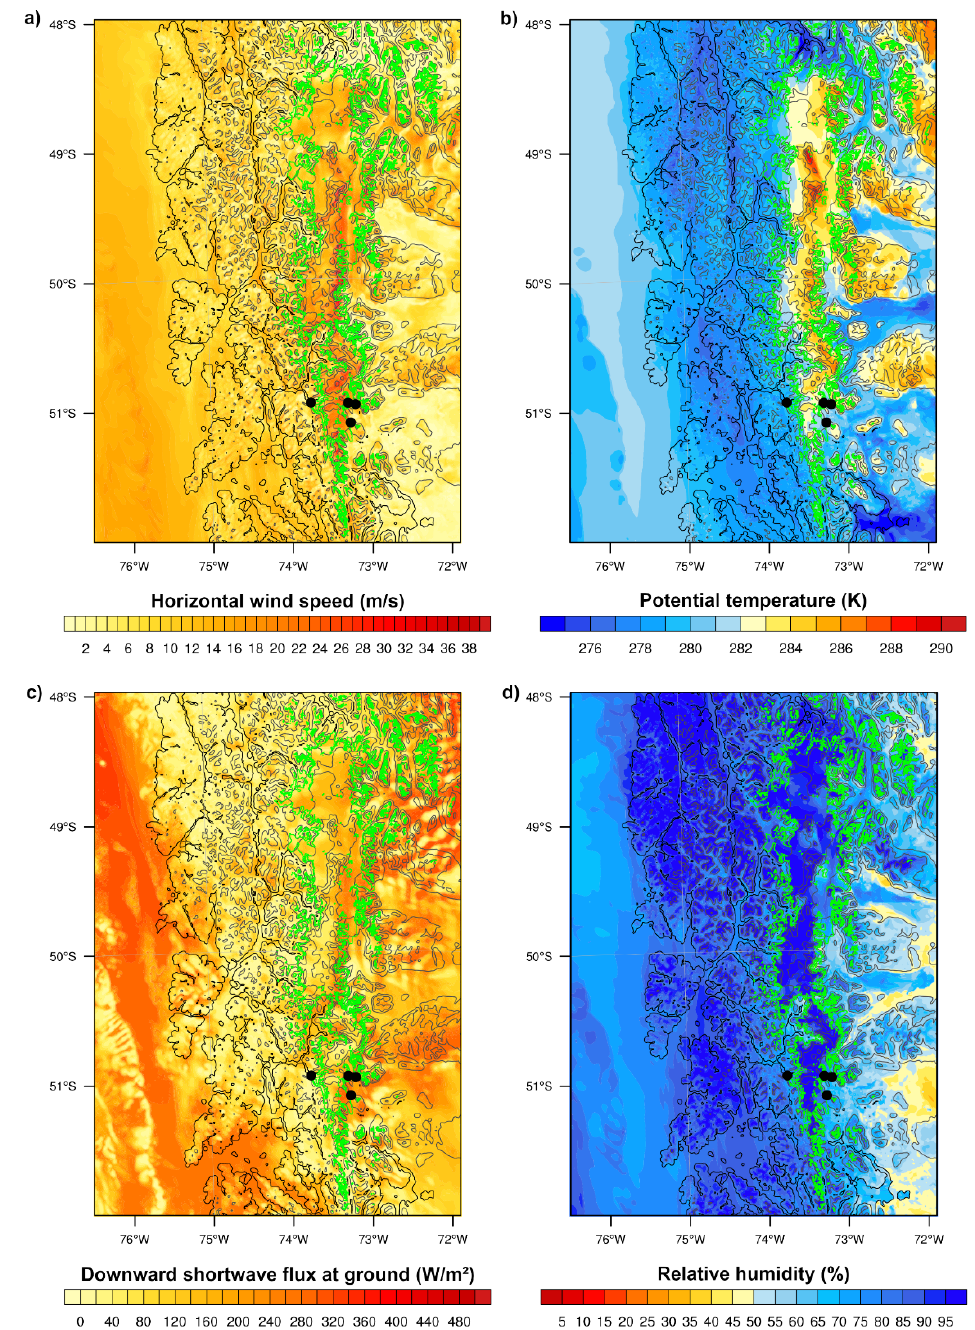
Figure 6. Surface conditions of ( a ) horizontal wind speed 10 m above ground, ( b ) potential temperature 2 m above ground, ( c ) downward shortwave flux at the ground, and ( d ) relative humidity 2 m above ground for the supercritical case on 20th July 2018 18:00. Black dots indicate the AWS locations. The green contour outlines the glacierized area. Black/grey contours mark the terrain height in 500 m intervals. Data are derived from WRF.